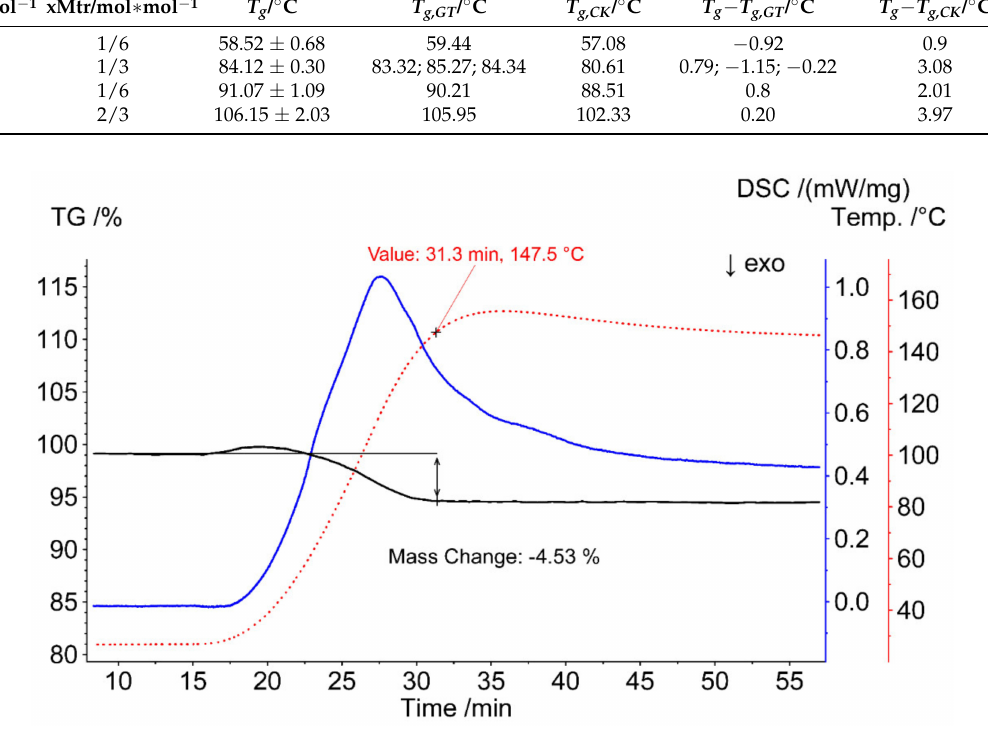
Figure A1. Exemplary simultaneous thermogravimetry and differential thermal analysis thermogram of a maltotriose sample with relatively high water content indicating a complete water release of 4.5% at about 148 ◦